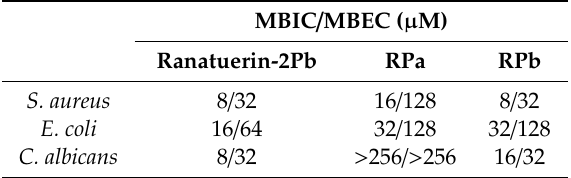
Table 4. Antibiofilm activity of peptides against tested